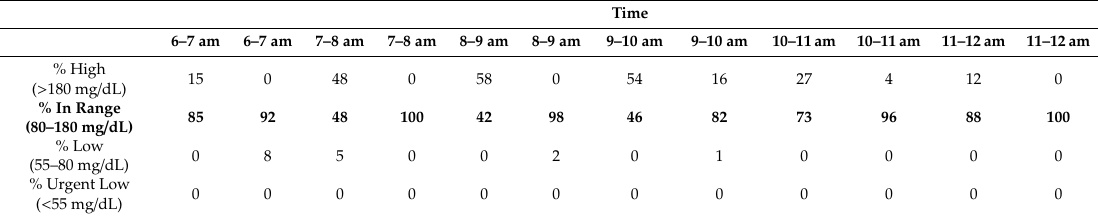
Table 3. Improving postprandial glycaemia when using the